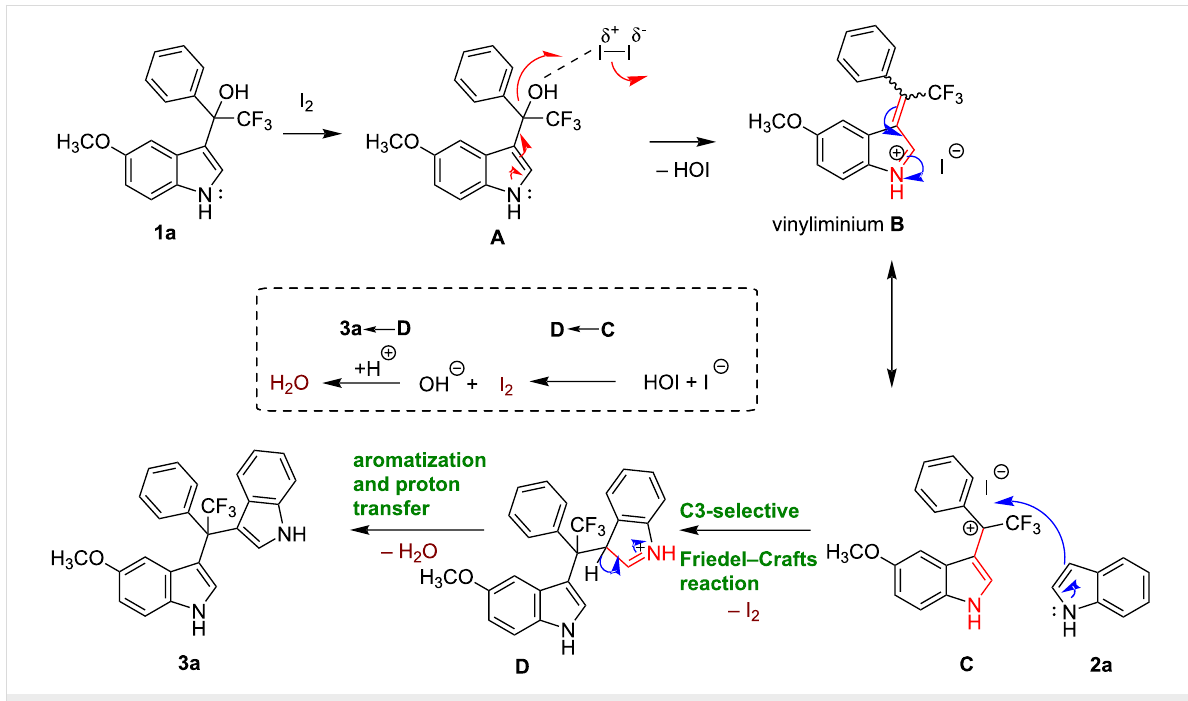
Figure 5: Plausible reaction mechanism for the synthesis of fluoromethylated unsymmetrical DIMs, shown for compound 3a as an example.